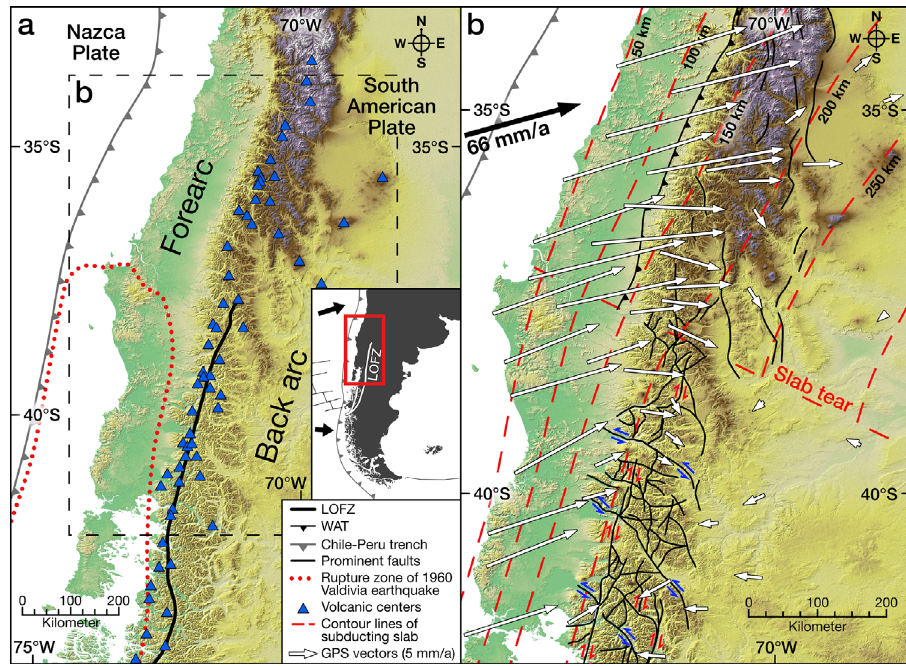
Fig. 1 Simpli fi ed morpho-tectonic maps of the Southern Andean Volcanic Zone (SVZ) based on Shuttle Radar Topography Mission data. a Map showing the Liquiñe-Ofqui Fault Zone (LOFZ) and the location of major volcanic centres 58 . b Map displaying prominent faults 10 – 12 , notably the Western Andean Thrust (WAT) 37 , contour lines of subducting slab 22 , and the GPS velocity fi eld 13 of the northern SVZ. The length of the plate convergence vector is not to